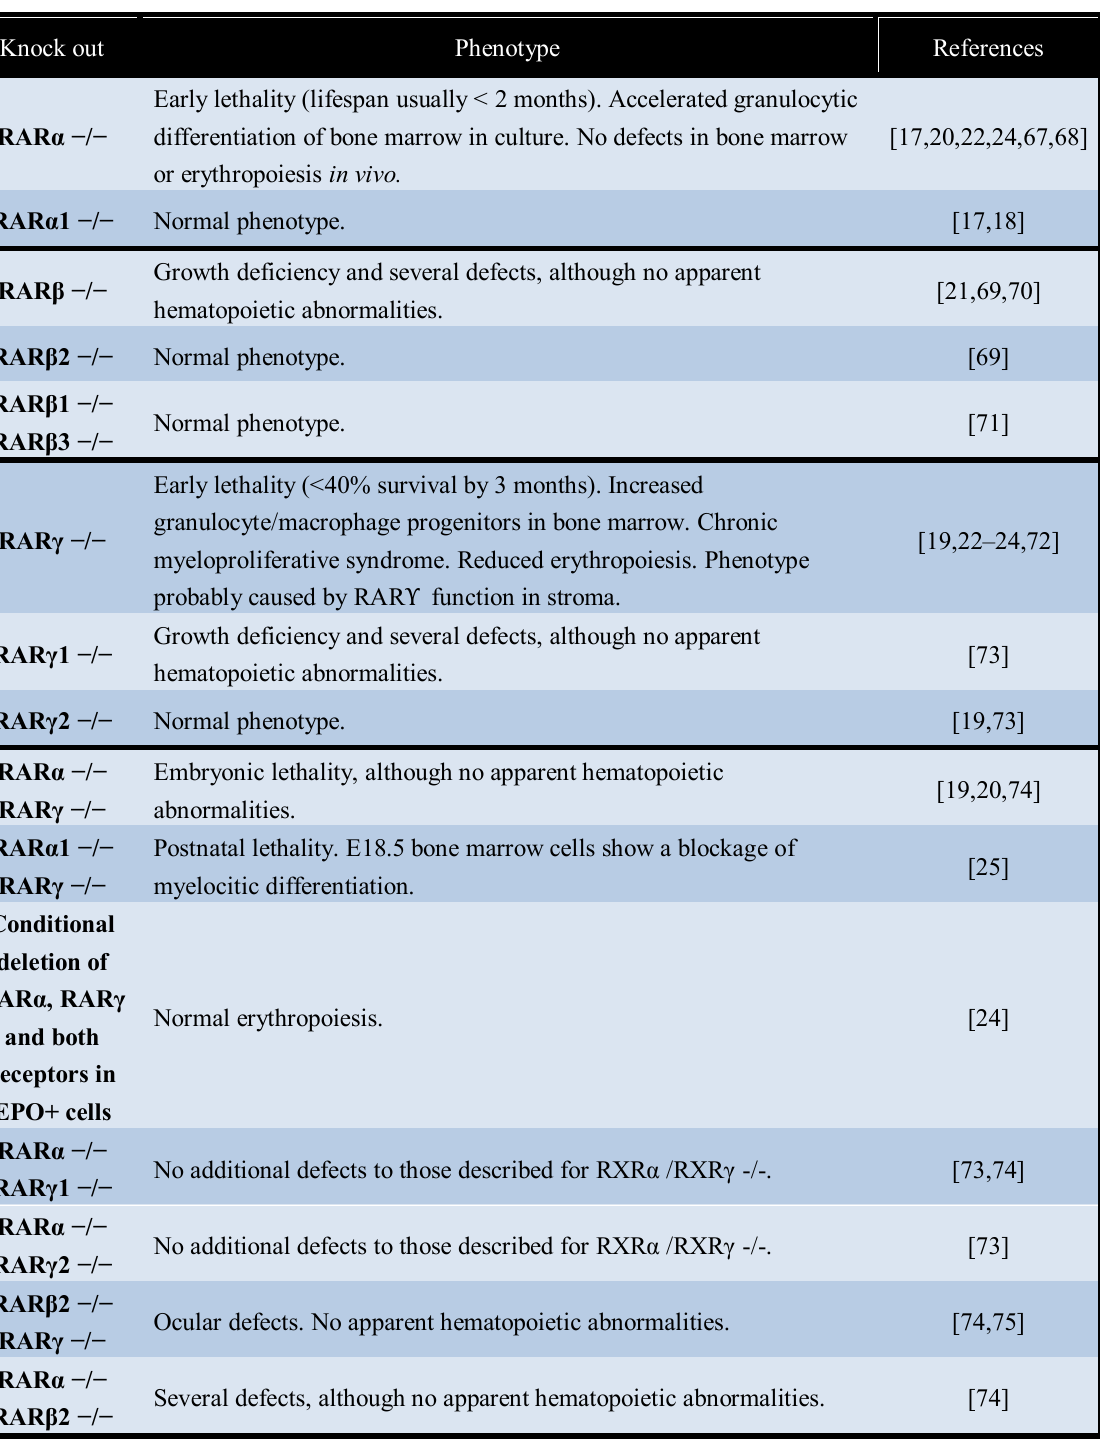
Table 1. Summary of the hematopoietic phenotypes derived from genetic or dietary alterations of the elements of the retinoic acid (RA) signaling